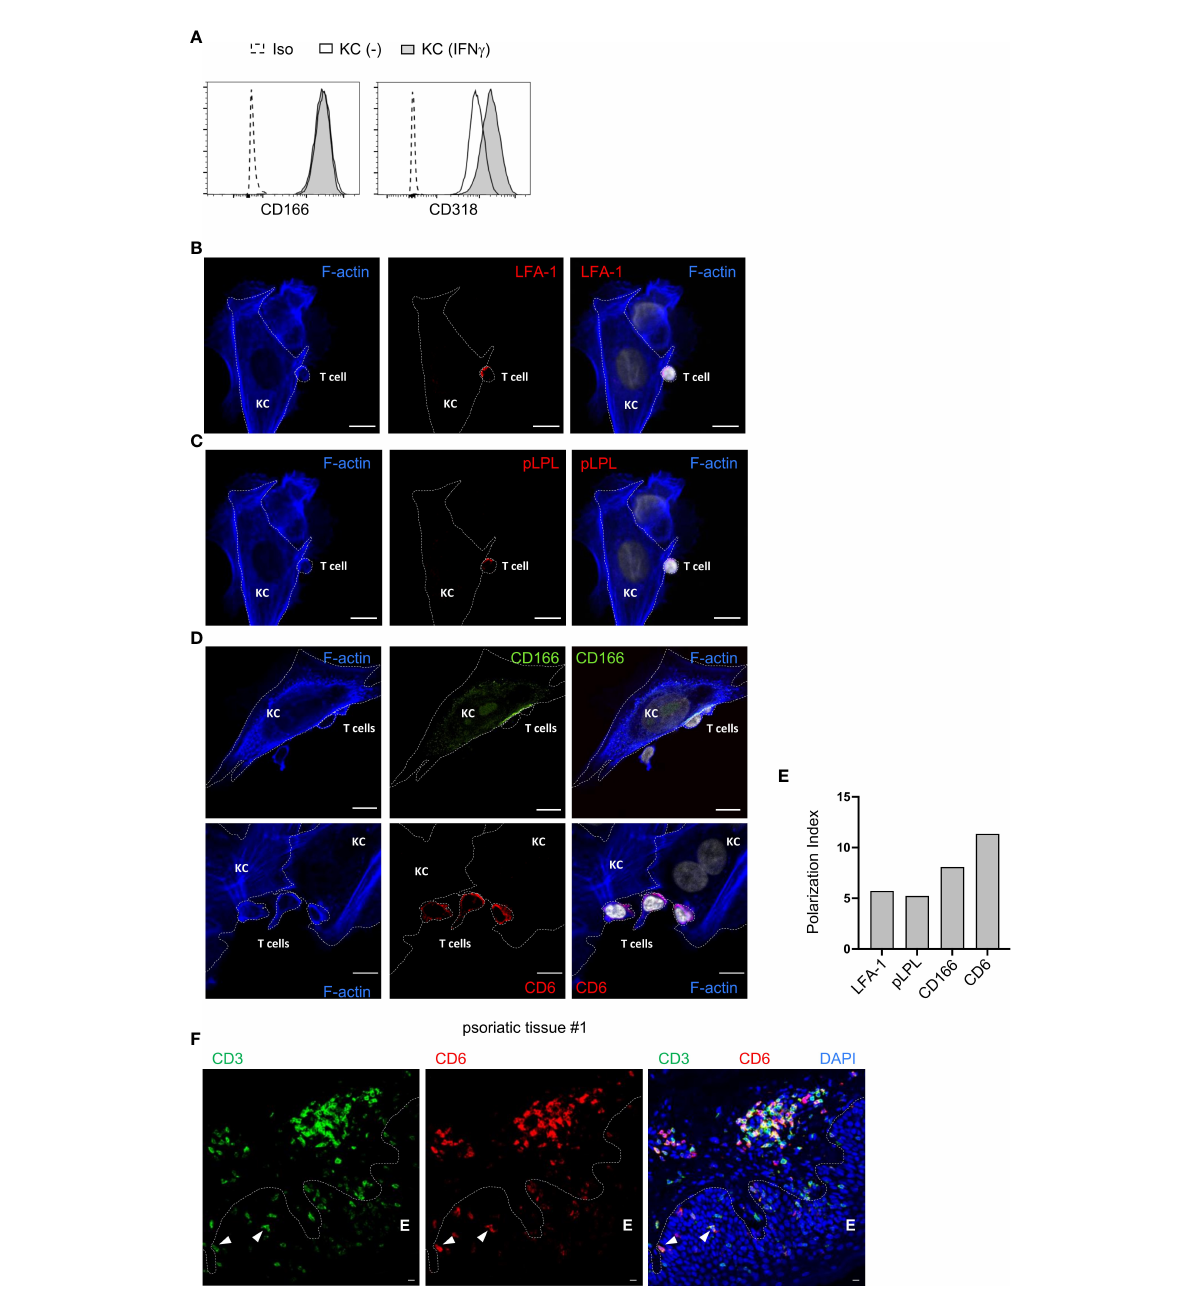
FIGURE 2 CD166 and CD6 accumulate at the contact zone between primary human keratinocytes and PBTs. (A) Flow cytometric analysis of ligands for costimulatory receptors on untreated KCs (black line, white fi lling) and KCs pretreated with IFN g for 24 h (black line, grey fi lling). Isotype control (Iso): dashed line, white fi lling. (B – D) Analysis of the contact zone between T cells and IFN g -pretreated and SEB-loaded KCs by confocal laser scanning microscopy (40x objective; NA = 1.3) after coculture for 4 h followed by immuno fl uorescence staining. (B) F-actin (blue), LFA-1 (red) and DAPI (white), (C) F-actin (blue), phospho L-plastin (pLPL, red) and DAPI (white), ( D , upper panel) F-actin (blue), CD166 (green) and DAPI (white), ( D , lower panel) F-actin (blue), CD6 (red) and DAPI (white). Shown are representative pictures for n=4 experiments. Cell borders are marked by dotted lines. Scale bar = 10 µm. Each panel on the right represents the overlay of all three respective stainings. (E) Polarization index (PI) of LFA-1, phospho L-plastin (pLPL), CD6 and CD166 at the contact zone of KCs and PBTs. PI: Signal intensity at contact zone/signal intensity on whole cell. (F) : Punch biopsies of psoriatic skin were stained for CD3 and CD6. Representative immuno fl uorescence staining of punch biopsies of skin lesions of psoriasis patient using Opal-4-color IHC kit [CD3 (green), CD6 (red), DAPI (blue)]. Dashed white line represents the border of epidermis E to dermis or hair follicle, respectively. White triangles highlight epidermal T cells highly expressing